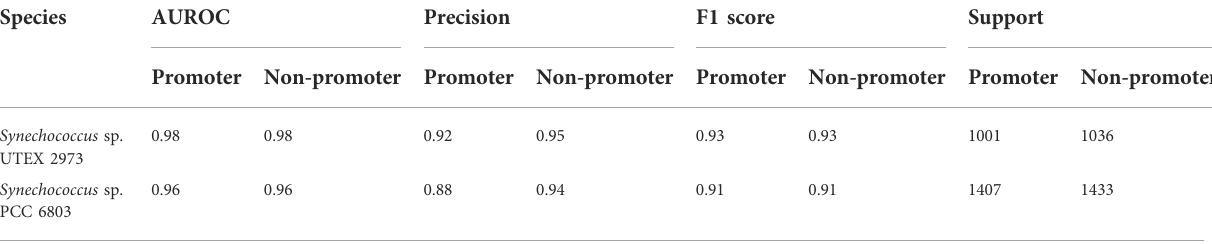
TABLE 4 Cross validation the performance of CyaPromBERT trained on Synechococcus elongatus sp. UTEX 2973 for a distantly related species Synechocystis sp. PCC 6803. Species AUROC Precision